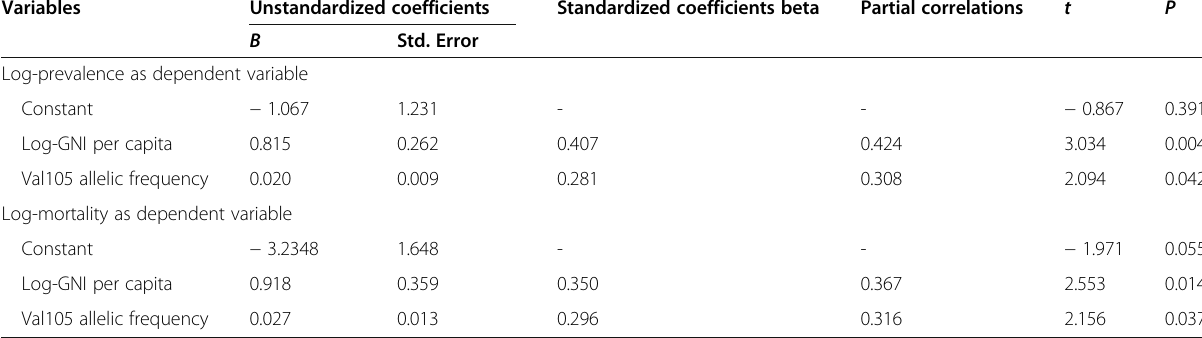
Table 2 Multivariable linear regression analysis for associations of log-mortality and log-prevalence of COVID-19 with the frequency of the Val105 allele in the various countries around the world